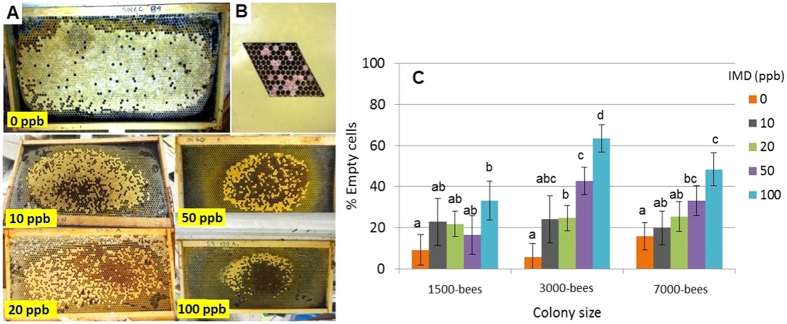
Examples of brood patterns from colonies chronically exposed to imidacloprid (0, 10, 20, 50 and 100 ppb) during brood rearing illustrating a dose-dependent effect where the amount of empty cells in a given brood area increases with treatment concentration (A); parallelogram containing 100 cells used to standardize brood pattern measures (B); and the average percentage (SE) of cells not containing pupae (empty) in a brood area of 100 cells separated by colony size (1500, 3000, and 7000 bees) and imidacloprid (IMD) dose (0, 10, 20, 50 and 100 ppb) (dose: F4, 39 = 10.9; p < 0.0001; colony size: F2, 39 = 2.1; p = 0.14; interaction effect: F8, 39 = 1.3; p = 0.3). Greater % of empty cells indicates worse brood patterns and overall brood health (C). Letters denote statistically significant differences among treatment levels within each colony size at α < 0.05. Results indicate significantly worse brood pattern (more empty cells), particularly at higher treatments (50 and 100 ppb), compared to untreated colonies.